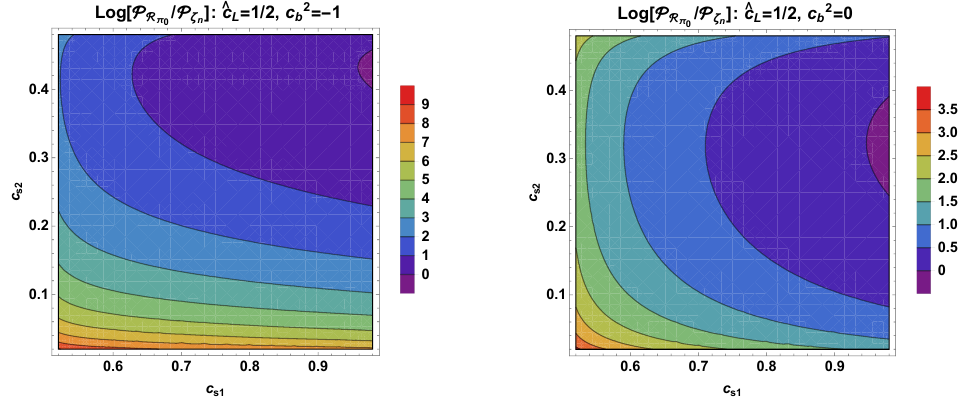
enhancement particularly π 0